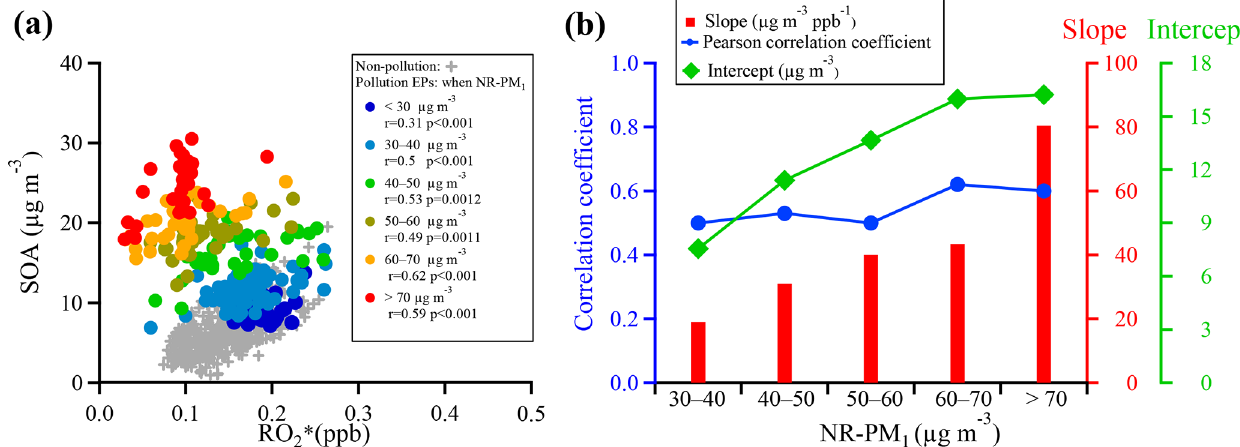
Figure 12. (a) Scatter plots of SOA and RO ∗ during pollution EPs at different NR-PM 1 mass concentration segments, and (b) correlation 2 coefficients, slopes, and intercepts of linear regressions between SOA and RO ∗ for NR-PM 1 mass concentration segments ranging from 30– 2 40 to > 70µgm − 3 . The regressions are orthogonally linear, and all correlations of the concentration segments were statistically significant ( p value < 0 . 01; see detailed statistical information in Table